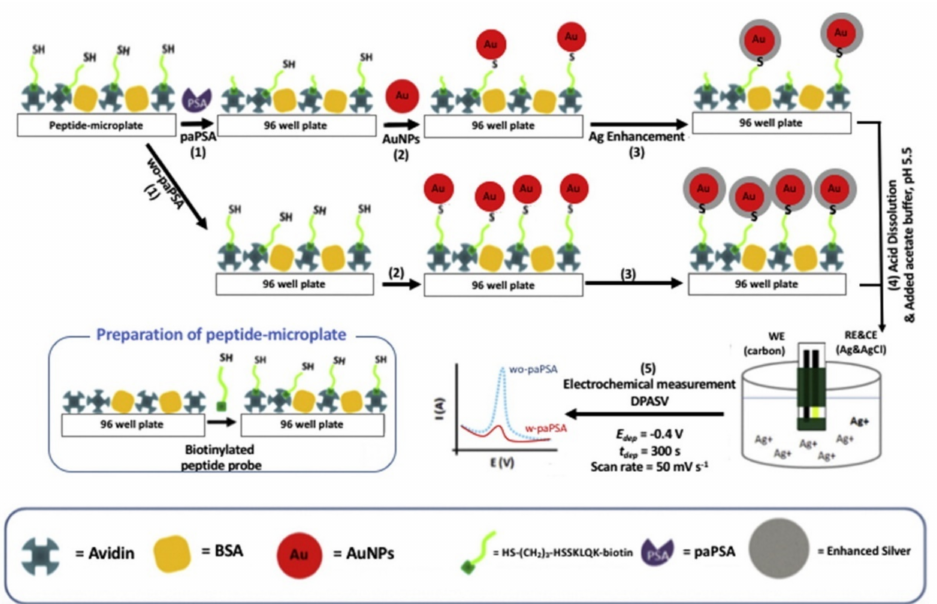
Figure 11. Determination of catalyzed peptide (paPSA) using differential pulse anodic stripping voltammetry (DPASV). Reprinted by permission from [92]. Copyright 2017 Elsevier.